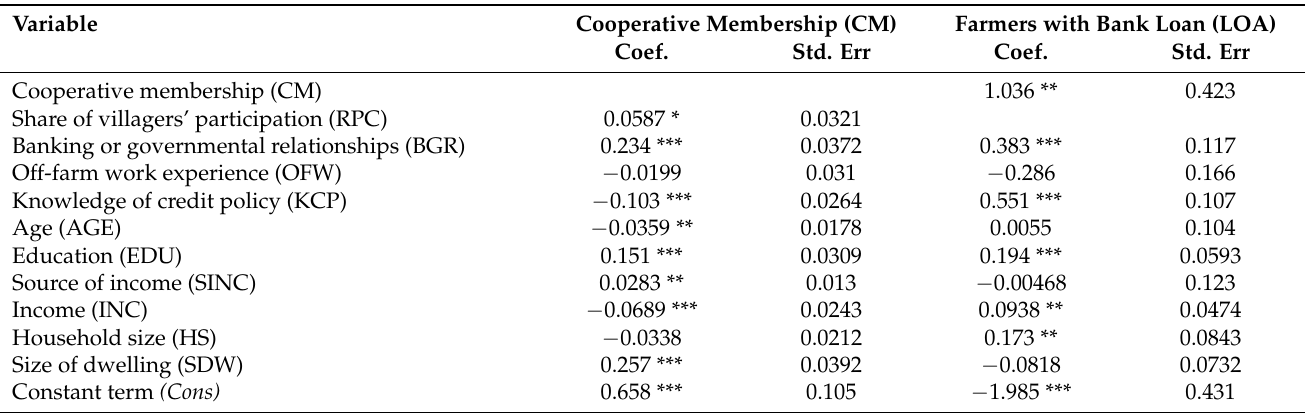
Table 4. Estimates of the IV-probit